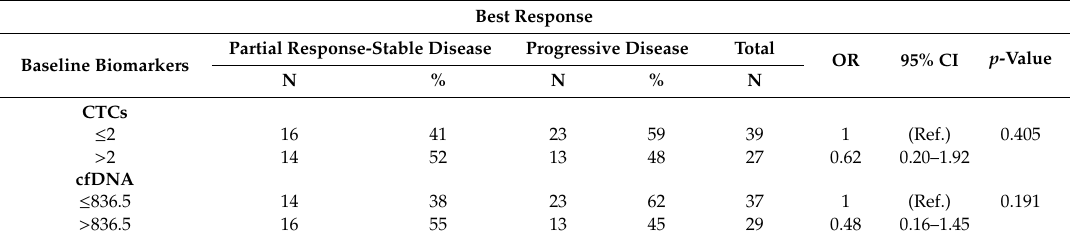
Table 3. Association of baseline CTCs and cfDNA with best response to nivolumab.